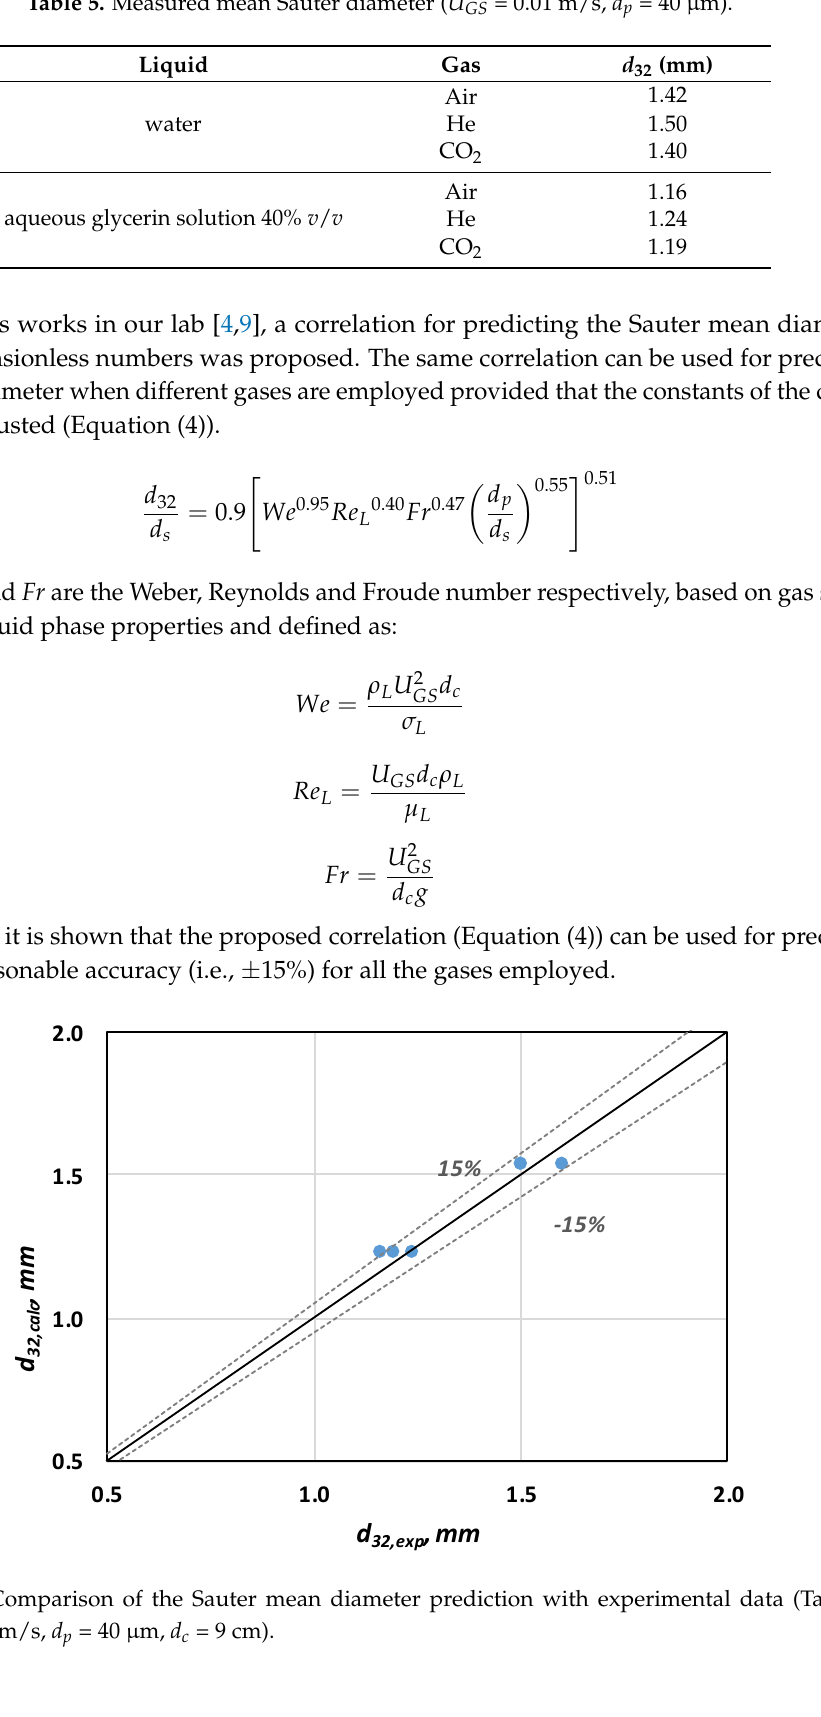
Table 5. Measured mean Sauter diameter ( U